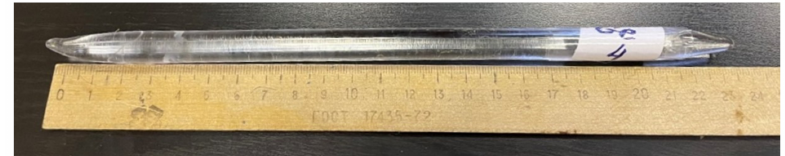
Figure 6. Fabricated core preform for MOF core supporting